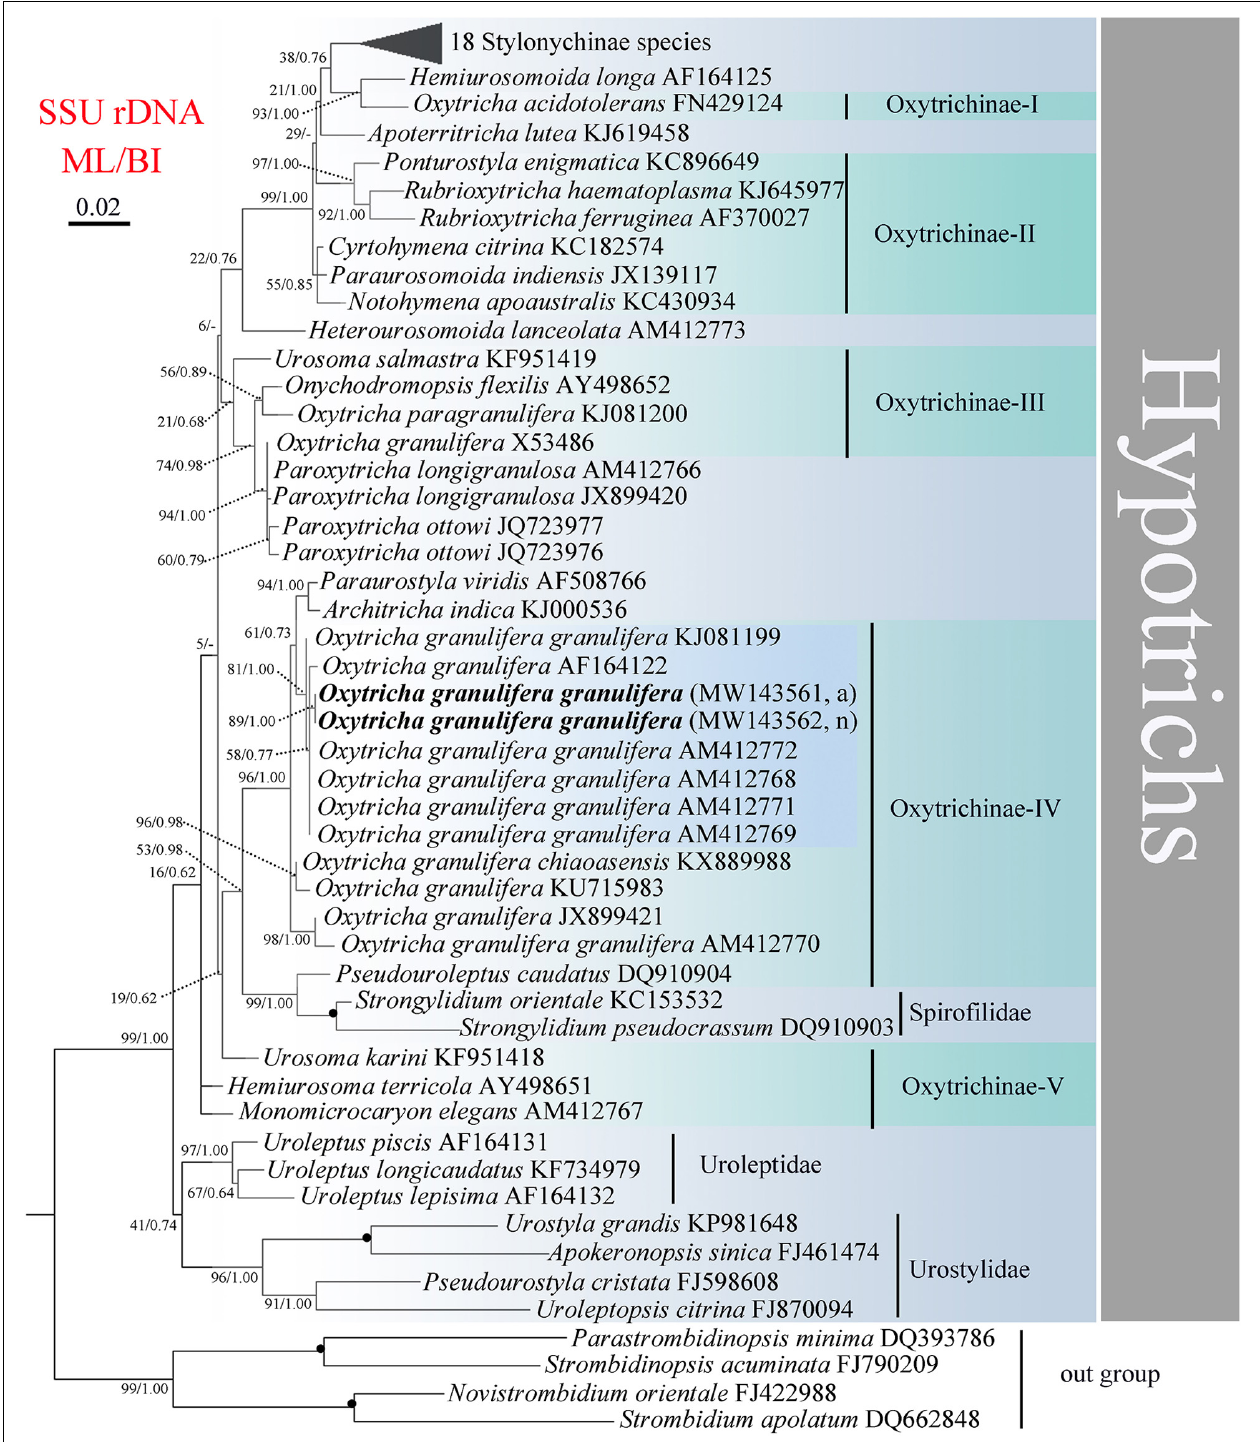
FIGURE 4 | Maximum likelihood (ML) phylogenetic tree inferred from SSU rDNA sequences of 67 hypotrichs. Phylogenetic positions of normal and abnormal forms of Oxytricha granulifera granulifera are indicated in bold. Black circles indicate full bootstrap values from both ML and BI (100/1.00). – indicates the topology disagreement between ML and BI, and only the bootstrap values of ML are shown. The scale bar corresponds to two substitutions per 100 nucleotide positions (0.02). a, abnormal form; n, normal form.